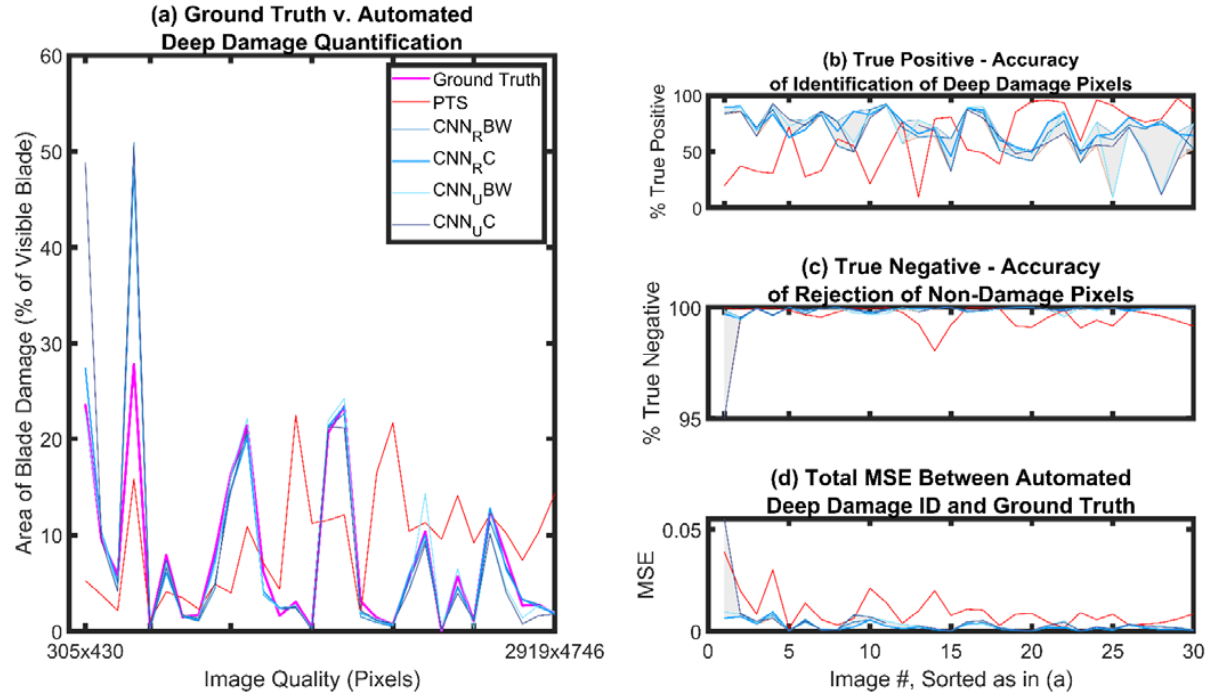
Figure 12. ( a ) Automated deep LEE quantification results for the unsupervised PTS module (red) and supervised CNN modules (blue) compared to subjective quantification for deep damage (magenta). ( b ) Accuracy of automated identification of deep LEE pixels compared to subjective identification. ( c ) Accuracy of rejection of non-LEE pixels compared to subjective identification (higher accuracy denotes fewer false positives in pixels assigned to the deep LEE class, i.e., less noise). ( d ) Total mean square error between automated and subjective deep LEE pixel identification. The gray shading shows the dispersion in the CNN results (maximum and minimum CNN results for each panel, i.e., b, c, and d, are used as the boundaries for the gray